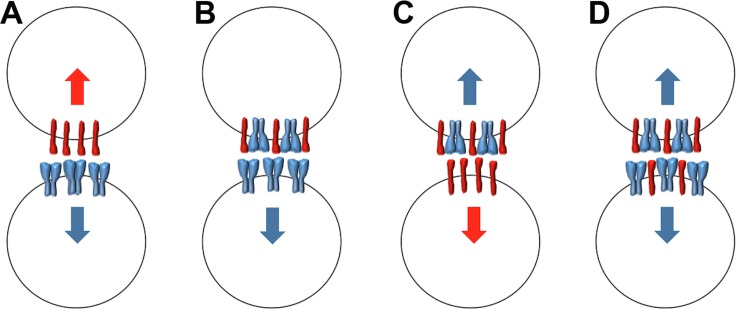
Schematic of diverse Sema6A-PlxnA2 interactions.Neighbouring cells are shown expressing either Sema6A (blue), PlxnA2 (red) or both molecules. (A) Signaling between cells expressing Sema6A alone and PlxnA2 alone can proceed in both directions (blue and red arrows). (B) Expression of Sema6A in cis blocks receptor function of PlxnA2 in the top cell but PlxnA2 can still act as a ligand to stimulate Sema6A receptor function in the bottom cell (blue arrow). (C) Sema6A-PlxnA2 complexes can act as receptors for PlxnA2 in trans (top cell), but not for Sema6A in trans (top cell in B). In some cases in vivo [12], Sema6A can still act as a ligand when co-expressed with PlxnA2 (red arrow, bottom cell). In others [10, 11, 51], PlxnA2 may directly occlude or indirectly antagonise this function (scenario not shown). (D) In populations of cells expressing both Sema6A and PlxnA2, the complexes should act as receptors for PlxnA2, through reverse signaling by Sema6A (blue arrows). The balance between these various interactions will likely depend on the precise stoichiometry of the proteins and may also be dynamically altered by interactions with additional proteins or newly encountered cells (e.g., ref. [53]).